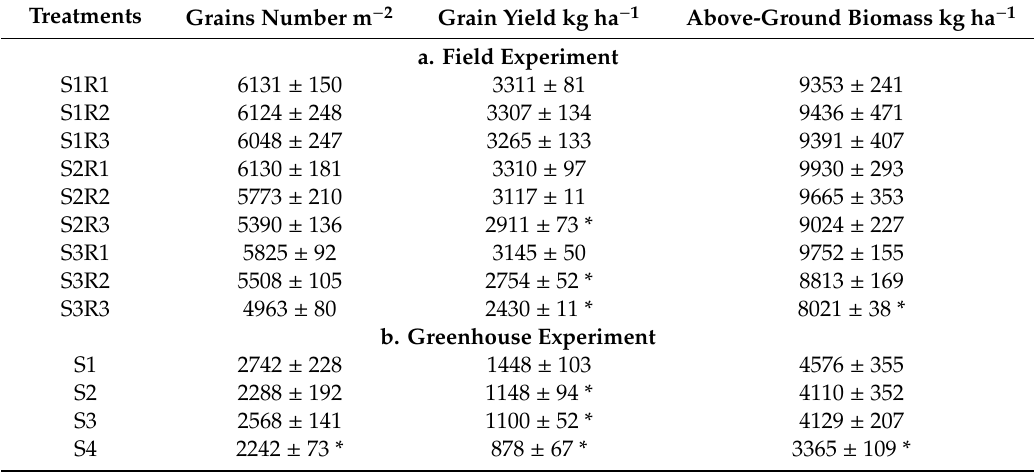
Table 4. Yield and yield components for the field ( a ) and the greenhouse experiments ( b ). The star symbol * shows significant values t < 0.05 using t -test assuming equal